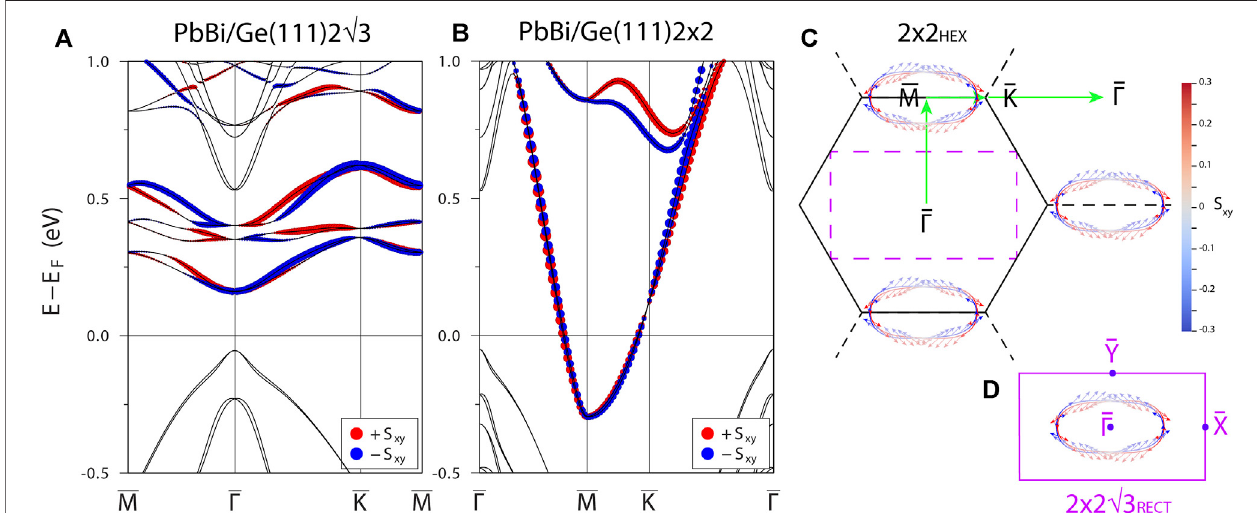
(cid:1)(cid:1) √ 3 -PbBi and (B) 2 × 2-PbBi phases on Ge(111). Panel (C) the projection of constant energy (cid:1)(cid:1) √ 3 surface BZ. Red and blue circles correspond to positive and negative in-plane spins S xy , while the symbol size